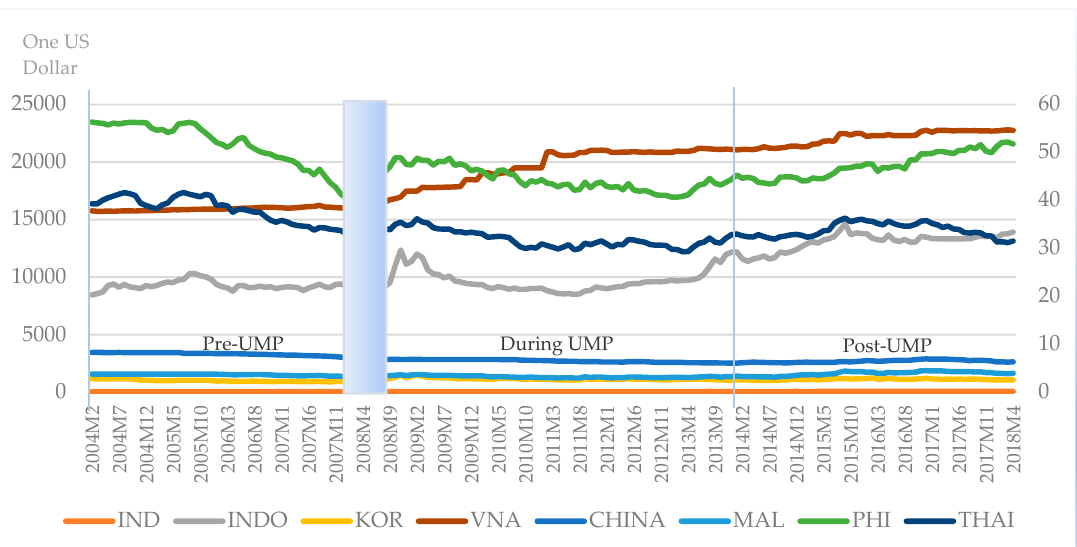
Pre-UMP During UMP Post-UMP